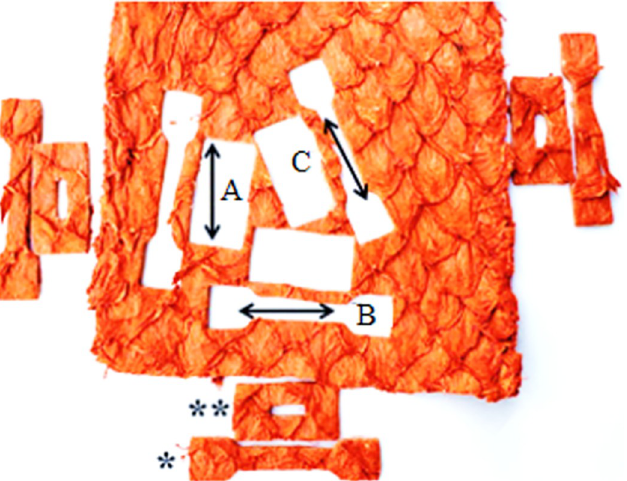
Fig 1. Paiche ( A . gigas ) leather with the removal of the specimens used for the tests to determine traction and elongation ( � ) and progressive tearing ( �� ). Specimens taken longitudinally (A), transversal (B) and diagonal (C) to the length of the fish